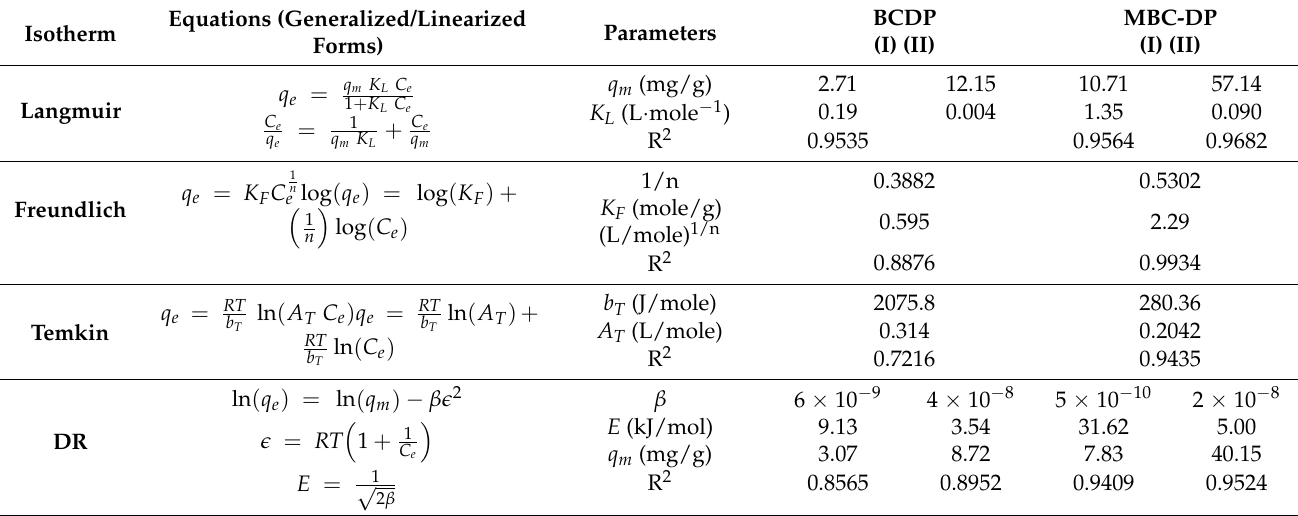
Table 6. General and linearized equations of Langmuir, Freundlich, Temkin, and Dubinin–Radushkevich isotherms. Equations’ parameters are also